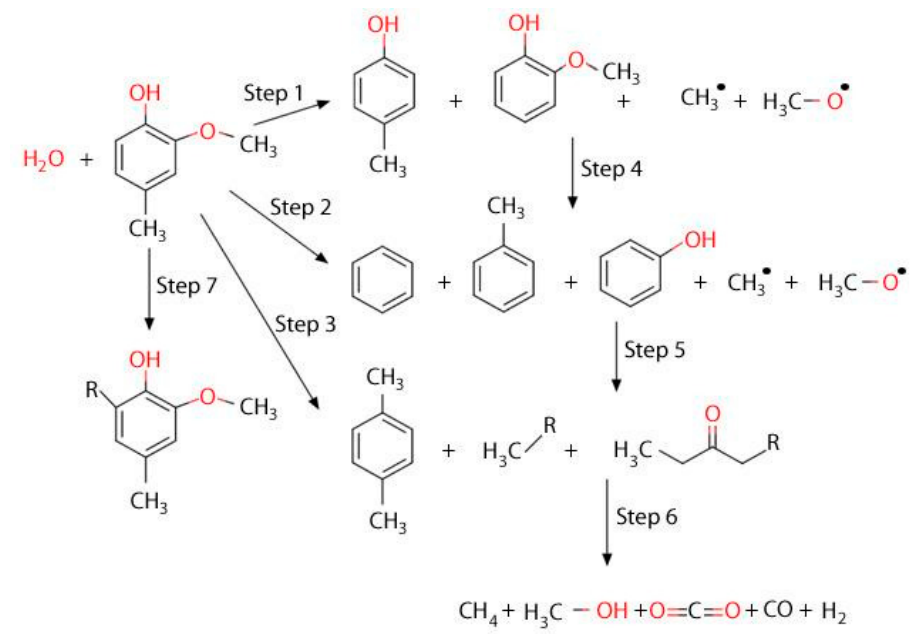
Figure 13. Postulated reaction mechanism for the catalytic conversion of 2M4MP using the Fe x O y /CaO- γ - Al 2 O 3 Catalyst .